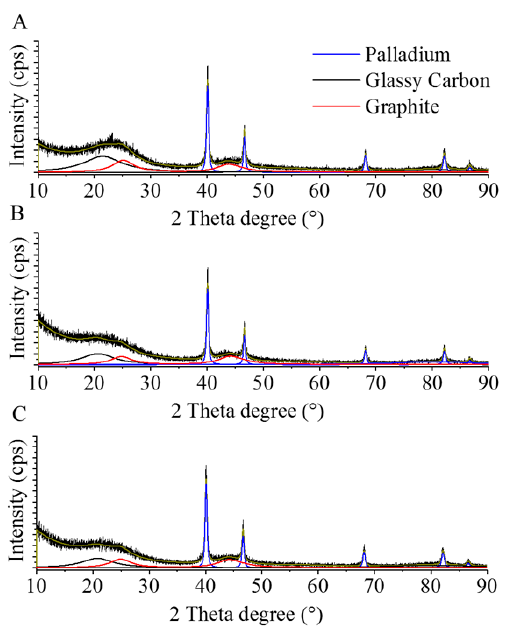
Figure 4. XRD pattern of the Pd/GCF ( A ), PD/GCF-AC1 ( B ), and Pd/GCF-AC2 ( C ) catalysts.